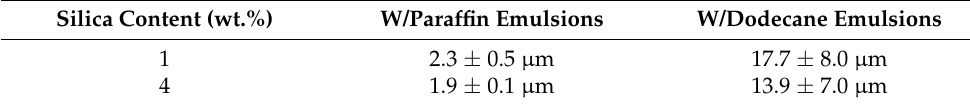
Table 3. Average droplet diameter of reverse Water/Paraffin and Water/Dodecane emulsions. Silica Content